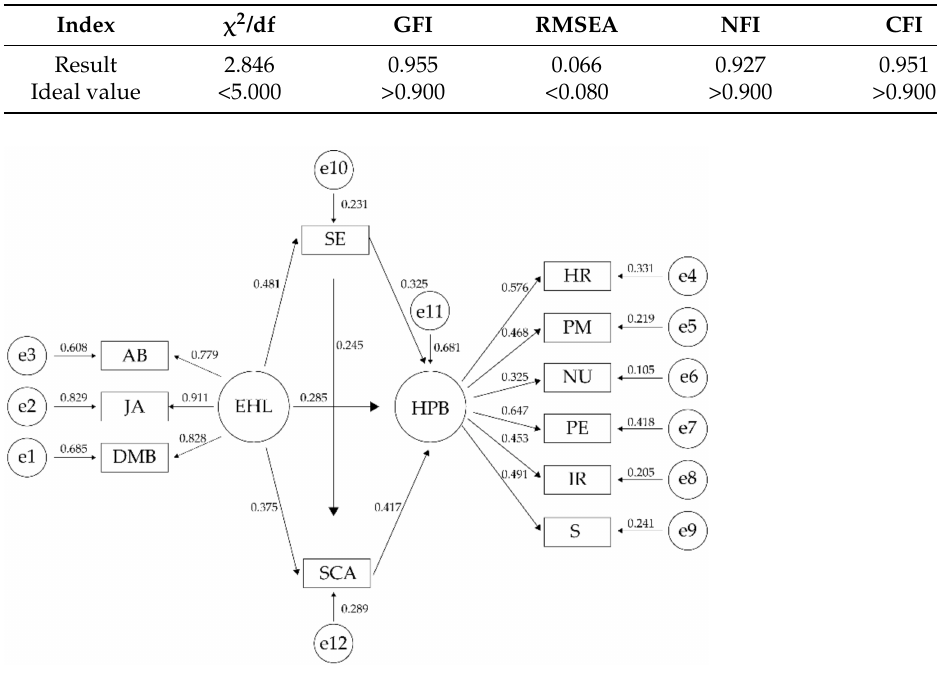
Figure 2. Path analysis model: eHealth literacy, self-efficacy, self-care ability, and health promotion behaviors. Note. EHL indicates eHealth literacy; AB indicates application ability; DMB indicates decision-making ability; JA indicates judgment ability; SCA indicates self-care ability; SE indicates self-efficacy; HPB indicates health promotion behaviors; HR indicates health responsibility; PM indicates pressure management; NU indicates nutrition; PE indicates physical exercise; IR indicates interpersonal relationship; S indicates spiritual growth. e1–e12 denote the measurement error of observed variables in estimating the latent